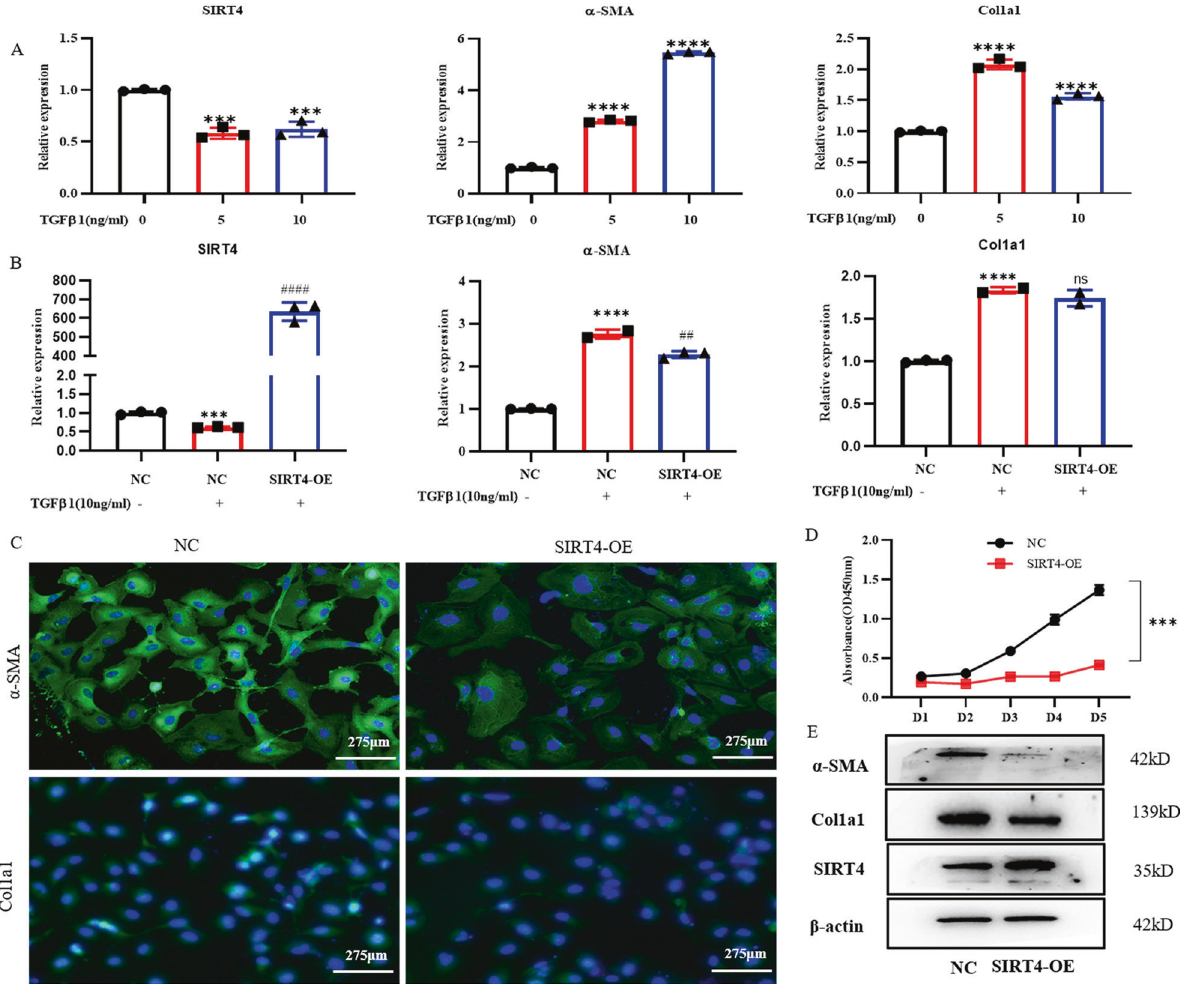
Fig. 5 Overexpression of SIRT4 ameliorated HSCs activation. A , B Real ‐ time quantitative PCR analysis of the mRNA expression of fi brotic genes. C Immuno fl uorescence analysis of α ‐ SMA expression (scale bars = 275 μ m). D Cell counting kit-8 (CCK-8) analysis of cell